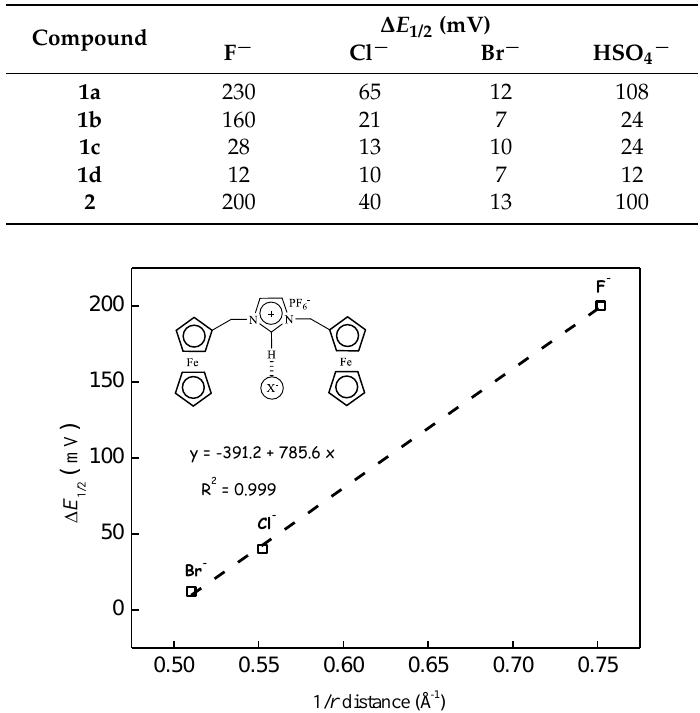
Figure 5. Anion-binding-induced potential shift as a function of the reciprocal of the radius of the halide ion in ligand 2 .